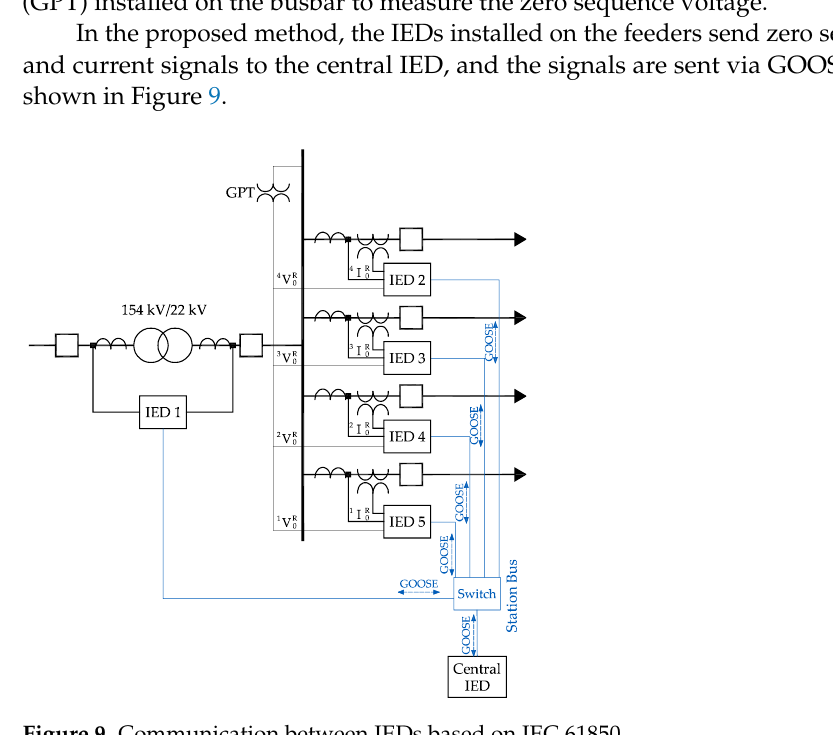
Figure 9. C ommunication between IEDs based on IEC 61850. Figure 9. Communication between IEDs based on IEC